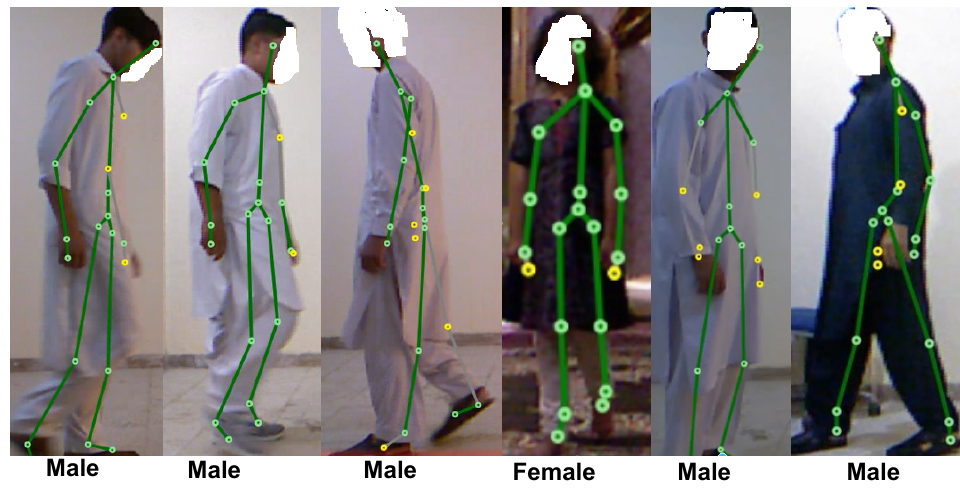
Figure 6. Gender classification in real time scenario.